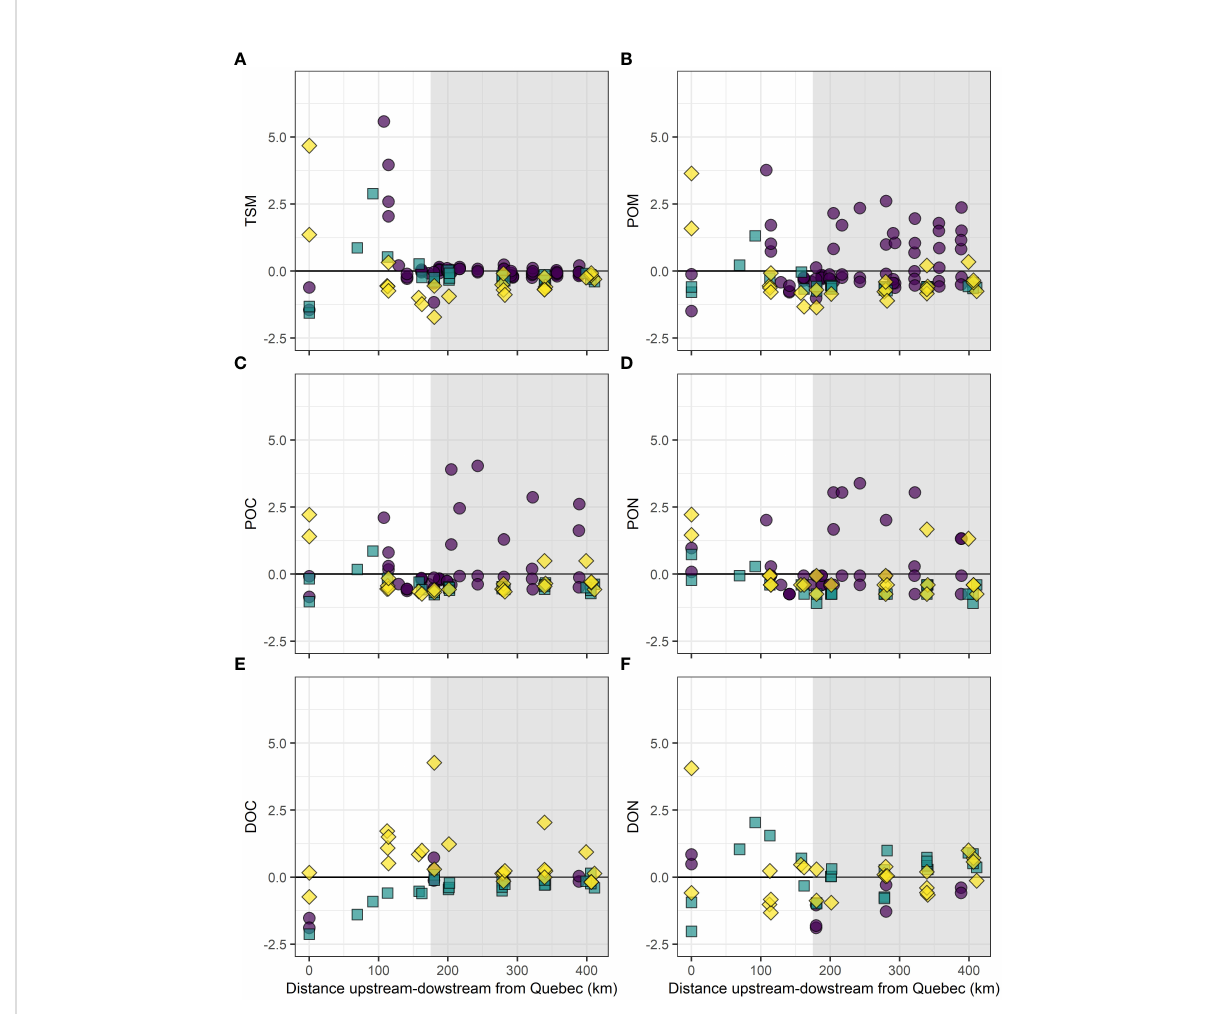
FIGURE 7 Surface water (A) TSM, (B) POM, (C) POC, (D) PON, (E) DOC, and (F) DON (see methods for details). Values from SLR were added to the plot for the corresponding months as the freshwater endmember. One unit represent a standard deviation. Purple circles = August 2016, turquoise squares